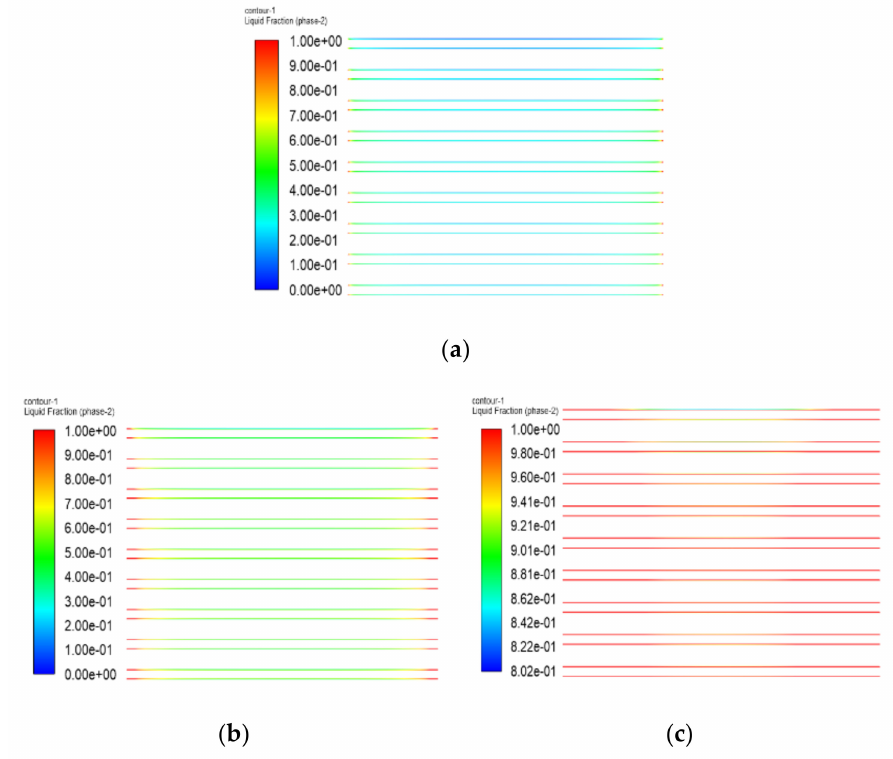
Figure 12. Liquid fraction contours of the ice at di ff erent times; ( a ) t = 24 s, ( b ) t = 28 s, ( c ) t = 32